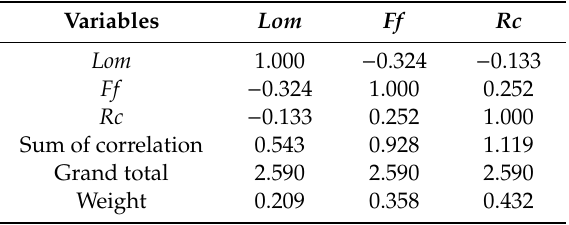
Table 9. Cross-correlation matrix of the Lom , Ff , and Rc variables of four HAL-MWs in Leimebamba and two HAL-MWs in Molinopampa (Amazonas, Peru).